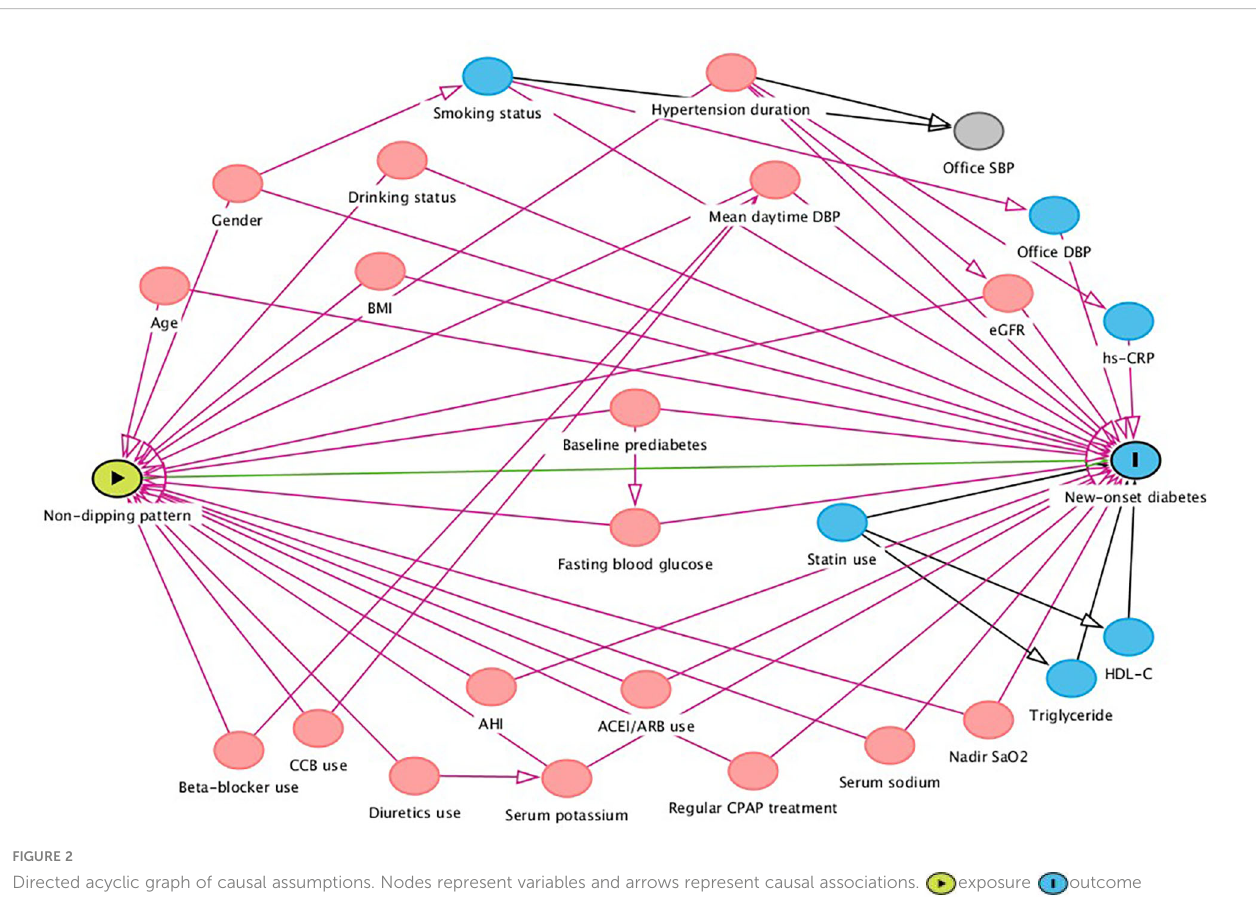
FIGURE 2 Directed acyclic graph of causal assumptions. Nodes represent variables and arrows represent causal associations. exposure outcome ancestor of exposure ancestor of outcome ancestor of exposure and outcome; SBP, systolic blood pressure; DBP, diastolic blood pressure; LDL-C, low-density lipoprotein cholesterol; HDL-C, high-density lipoprotein cholesterol; hs-CRP, high sensitivity C-reactive protein; eGFR, estimated glomerular fi ltration rate; ACEI, angiotensin-converting-enzyme inhibitor; ARB, angiotensin II receptor blocker; AHI, apnea hypopnea index; SaO 2 , oxygen saturation; CPAP, continuous positive airway pressure.